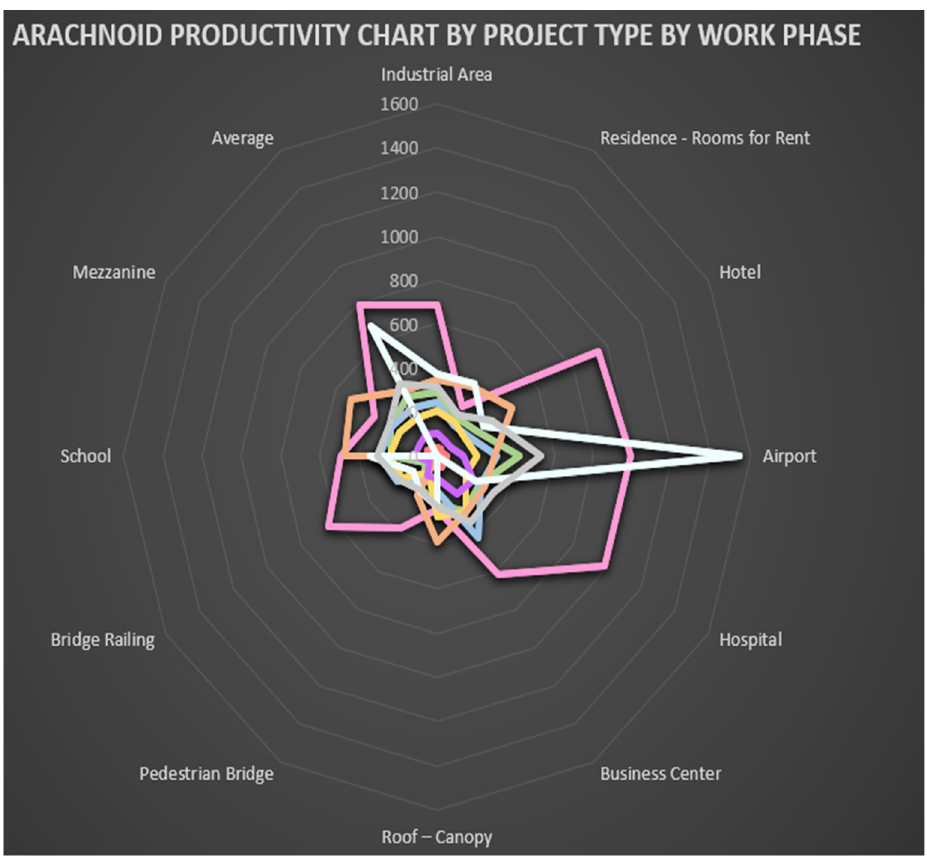
Figure 2. Productivity—Arachnoid diagram of average productivity by project type by work phase.